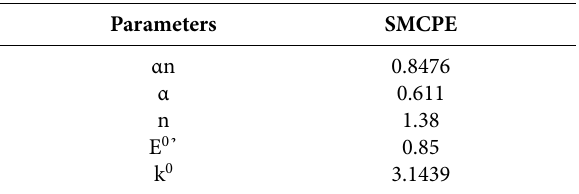
Table 2. Performance data of the proposed SWV method for deter- mination of SLC